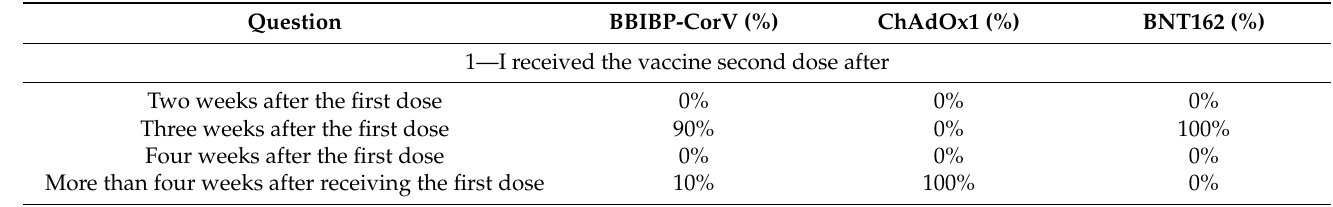
Table 3. Postvaccine second-dose side effects and